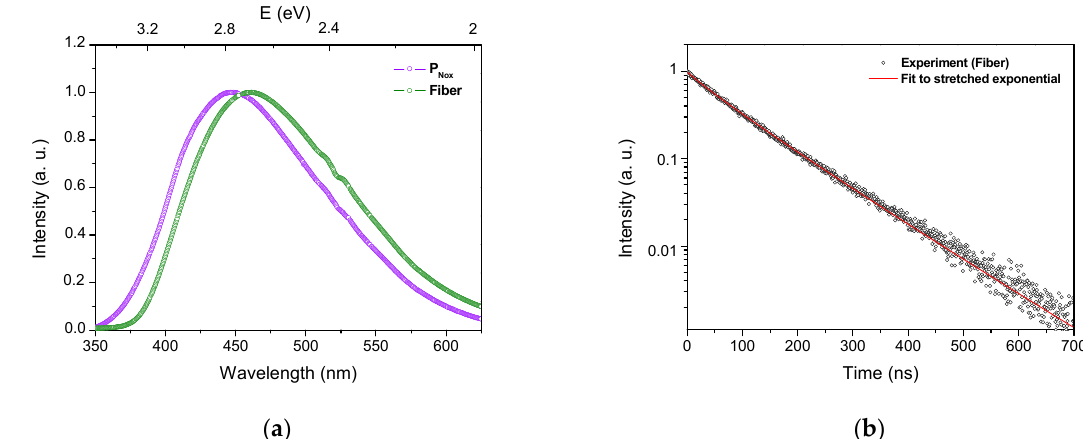
Figure 6. ( a ) Normalized PL spectra of Ce-doped optical fiber and its corresponding P Nox preform under 320 nm laser excitation. ( b ) PL decay curve at 450 nm, after probe excitation at 320 nm and a fit using Equation (1).